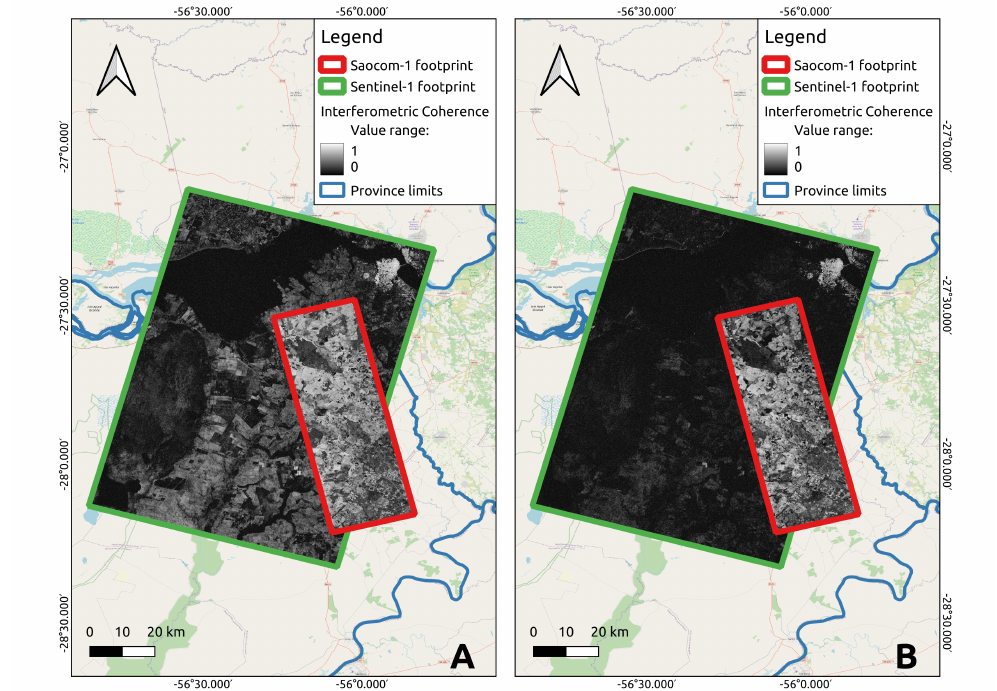
Figure 4. Comparison of the | γ VV | for SAOCOM-1 (red) and Sentinel-1 (green). ( A ) SAOCOM-1 16-day (September) interferogram and a Sentinel-1 12-day (September). ( B ) 48-day interferogram for both systems